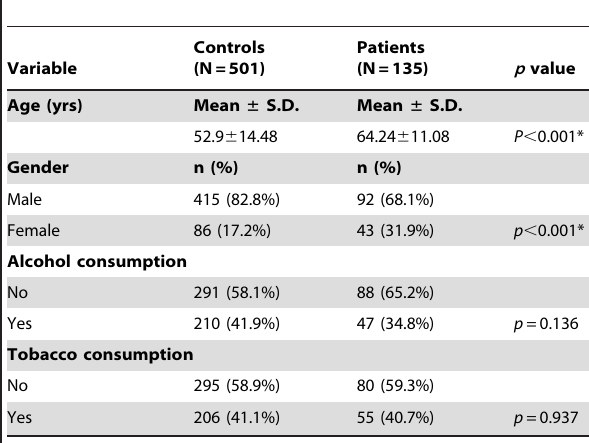
Table 2. The distributions of demographical characteristics in 501 healthy controls and 135 patients with